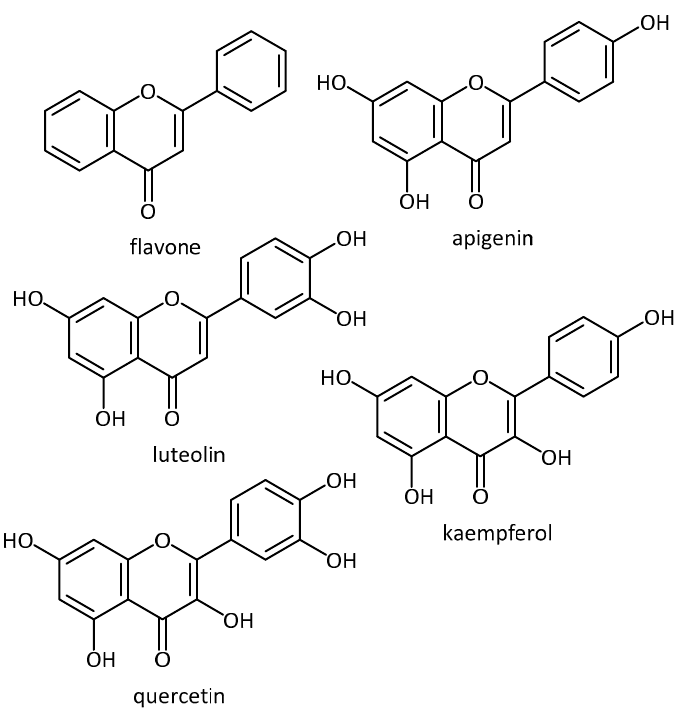
Figure 6. Structure of antioxidant flavonoids.